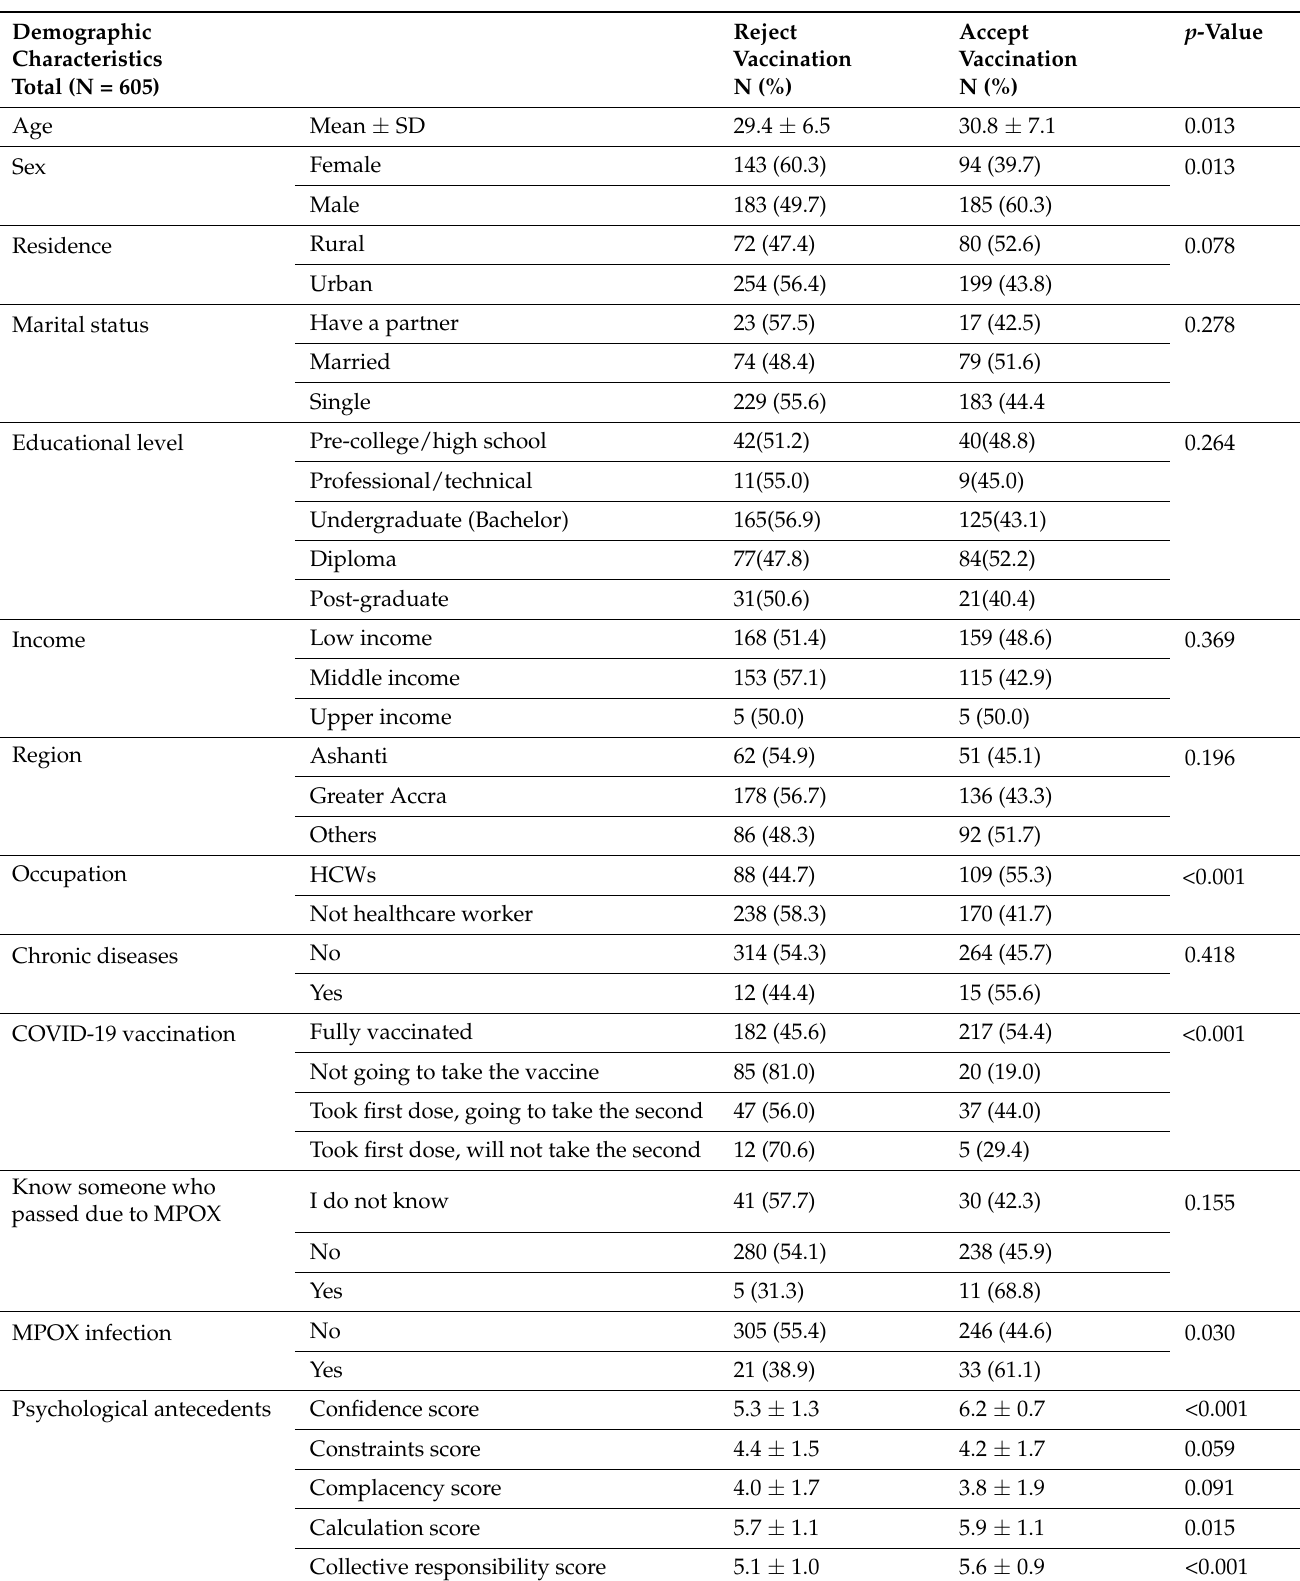
Table 2. Different sociodemographic criteria and participants’ attitudes across their intention to receive a vaccination, (n =